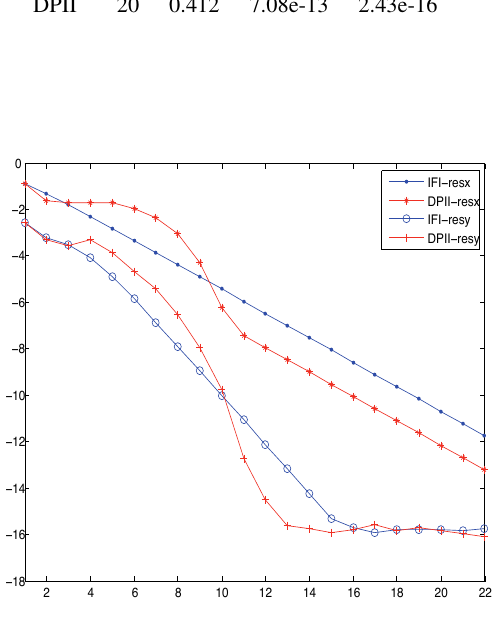
Fig. 2. Residual history for Example